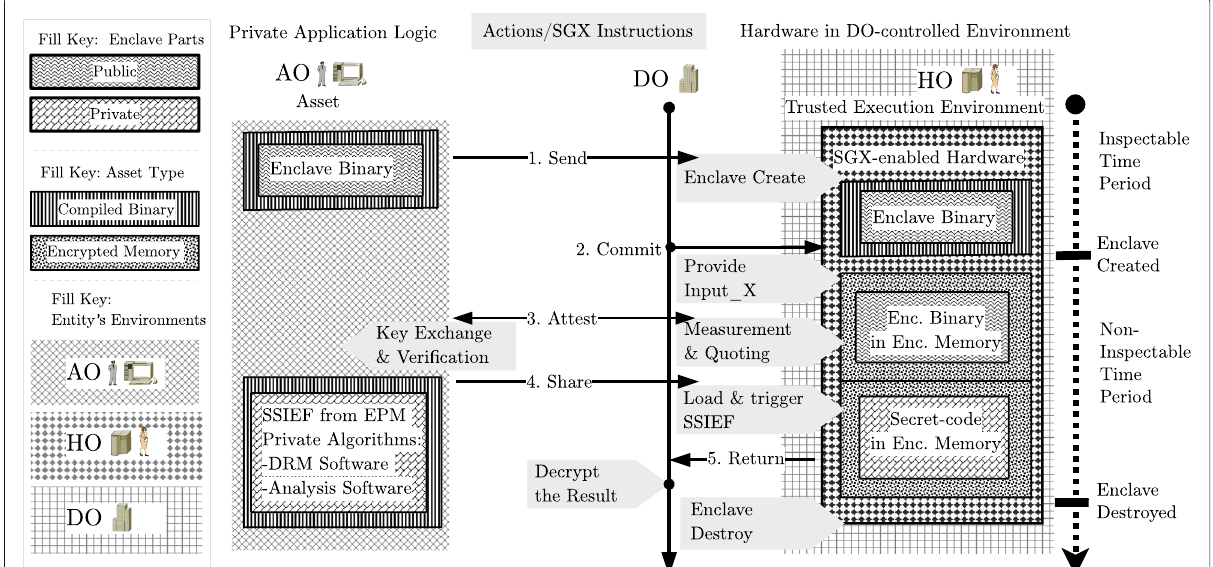
Fig. 10 Secret-Code Execution (SCE) Querying the Algorithm. The DO provides an input to the secret algorithm and receives the output. Input commitment prevents querying the secret-code with a different parameter in an offline repeated execution